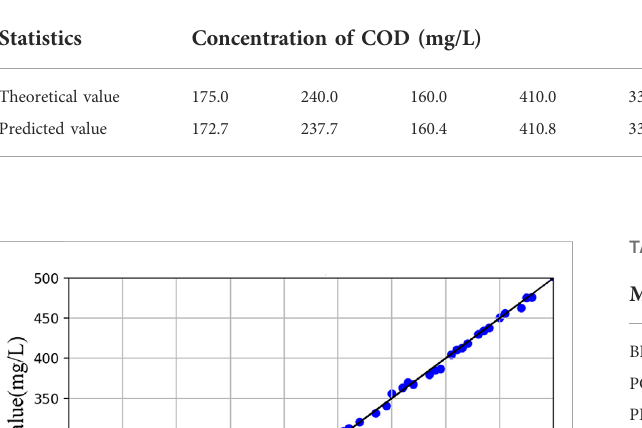
TABLE 1 Prediction results of our network model.